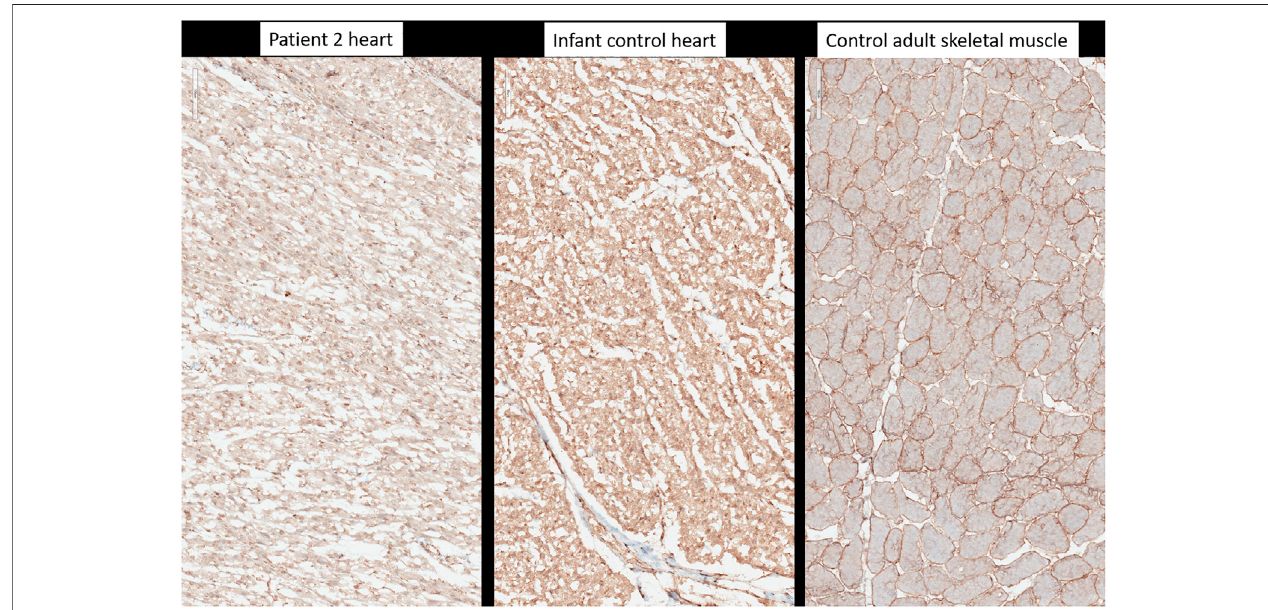
FIGURE4| Immunohistochemistry with anti-alpha-dystroglycan(clone VIA4-1, Sigma-Aldrich-Merck, Germany). Heart tissueofpatient2,hearttissue ofahealthy age-matched control, control from adult skeletal muscle.